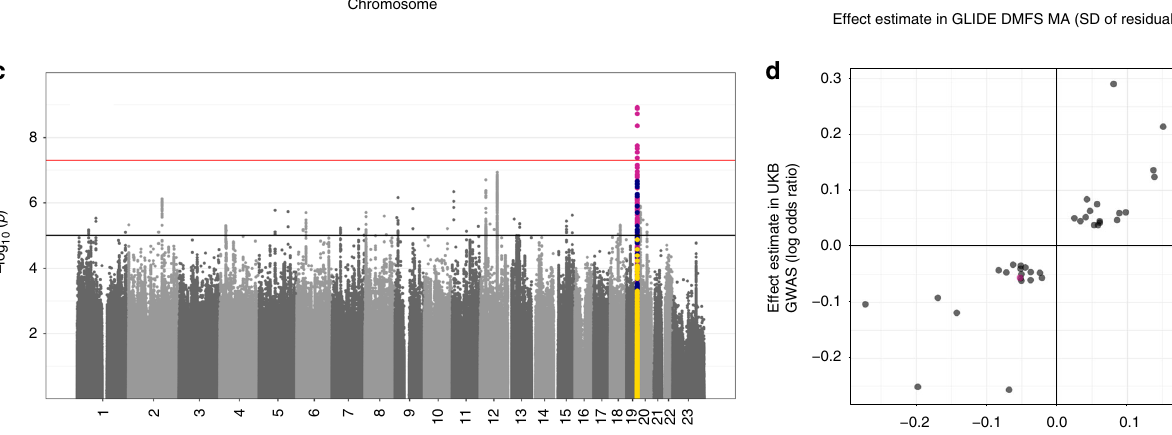
0.1 Effect estimate in GLIDE MA (log odds ratio) Fig. 2 Single-variant results in combined analysis of GLIDE and UKB. a Manhattan plot of the DMFS/dentures combined analysis. The red line indicates the threshold for genome-wide signi fi cance at ( P = 5 × 10 − 8 ), and the black line indicates a suggestive threshold for association at ( P = 1 × 10 − 5 ). Loci achieving genome-wide signi fi cance in the combined analysis (Z-test) are coloured in magenta. P- values for the same loci are shown in blue for dentures in UKB and yellow for DMFS in GLIDE. b Concordance of genetic effects in the DMFS/dentures combined analysis. Each point represents a conditionally independent signal of association ( P < 5 × 10 − 8 ). c Manhattan plot of the periodontitis/loose teeth combined analysis. The red line indicates the threshold for genome-wide signi fi cance at ( P = 5 × 10 − 8 ), and the black line indicates a suggestive threshold for association at ( P = 1 × 10 − 5 ). The single-locus meeting this threshold is coloured in magenta. P -values for the same locus are shown in yellow for periodontitis in GLIDE, and blue for loose teeth in UKB. d Concordance in genetic effects in the periodontitis/loose teeth combined analysis. The magenta point represents the single locus with P < 5 × 10 − 8 , grey points represent conditionally independent suggestively associated loci with P < 1 × 10 − 5 in combined analysis